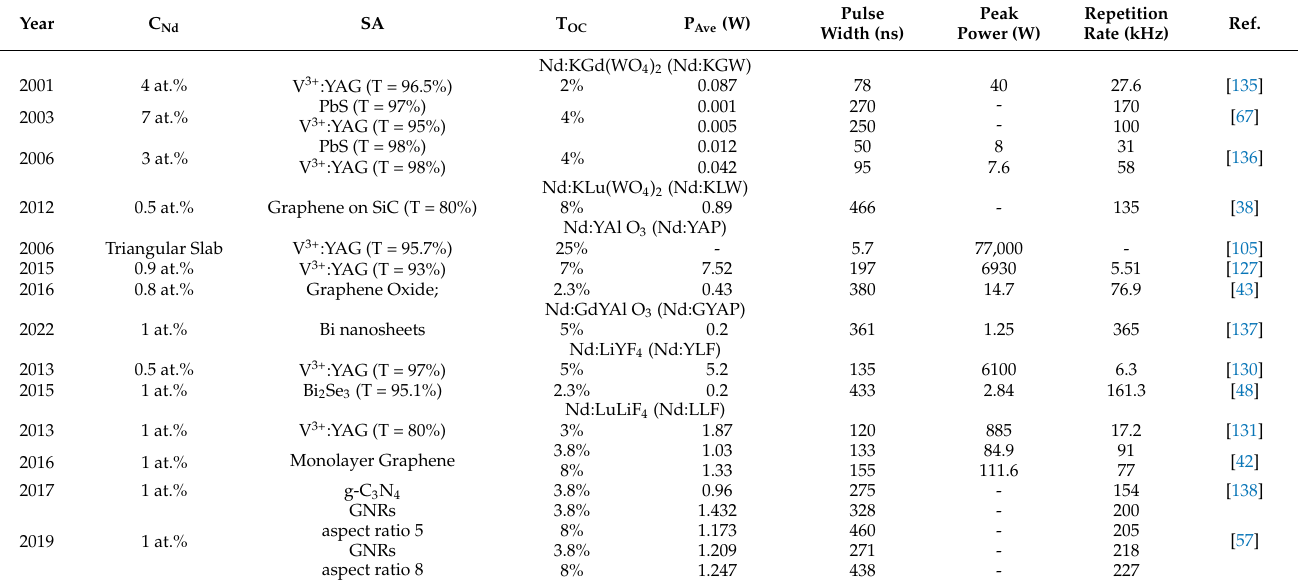
Table 5. Research progress on 1.3 µ m passively Q-switched Nd:KGW, Nd:YAP, Nd:YLF, and Nd:LLF